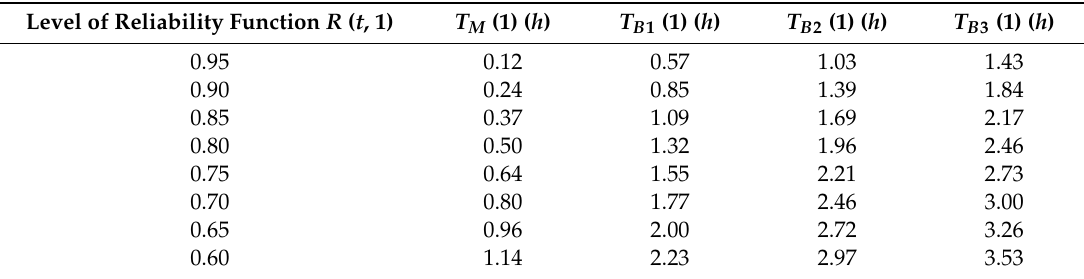
Table 2. Comparison of moments of exceeding the level of reliability function coordinate R ( t , 1) for di ff erent system configurations depending on the number of back-up